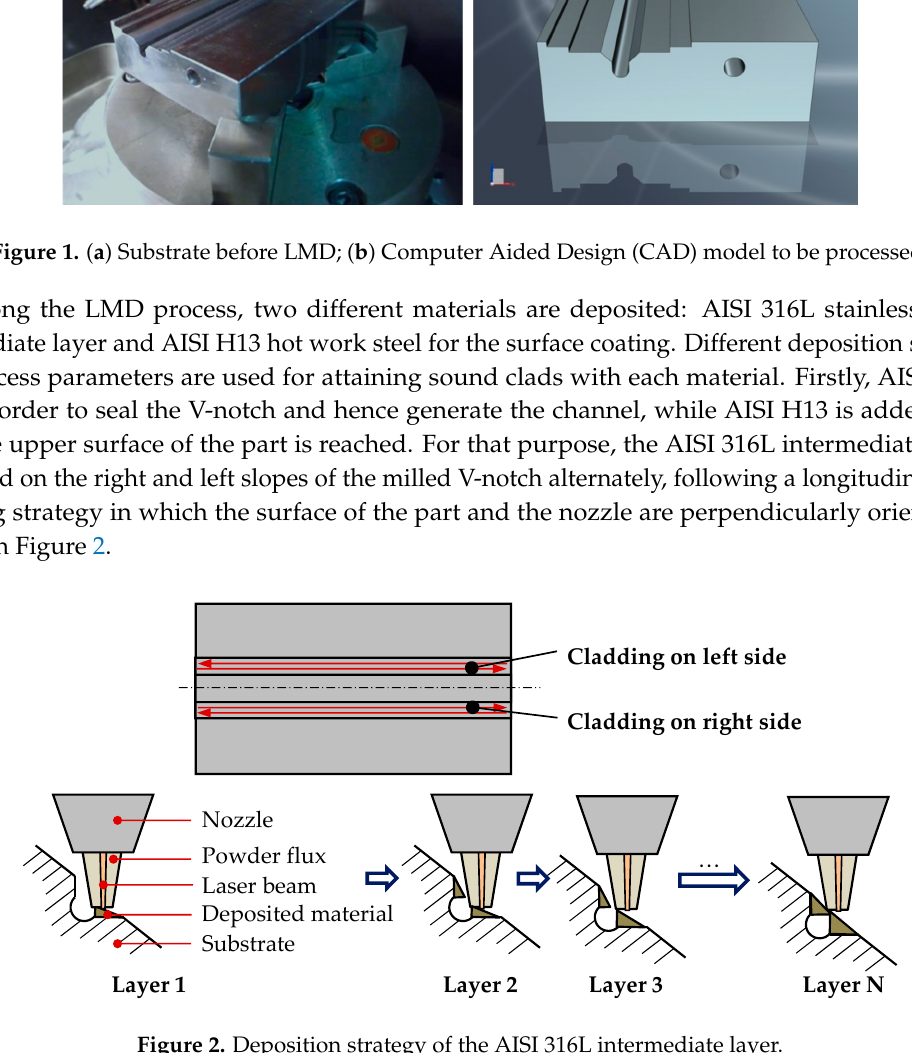
Figure 2. Deposition strategy of the AISI 316L intermediate layer.